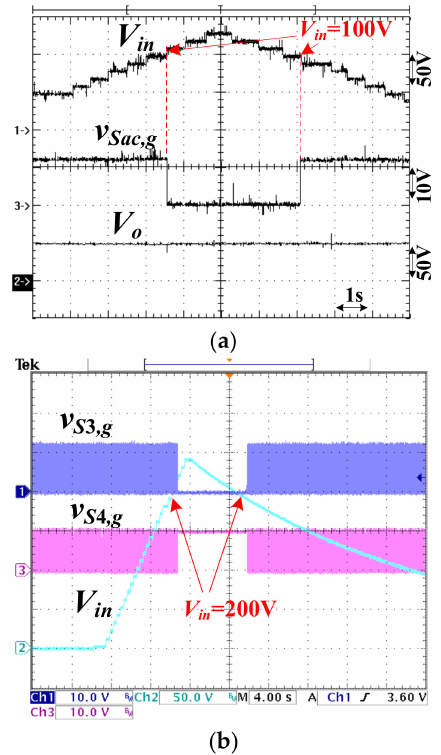
Figure 14. Measured waveforms: ( a ) V in , v Sac and V o ; ( b ) V in , v S3 , g and v S4 , g